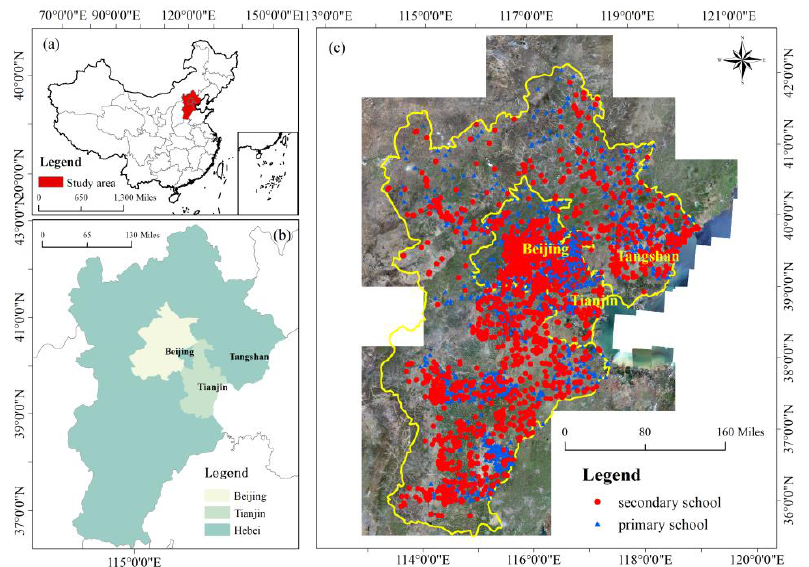
Figure 6. Display of study area: ( a ) the study area in China; ( b ) the Beijing – Tianjin – Hebei region; ( c ) the datasets used in our study. Note: the secondary and primary schools are plotted by the red circles and blue triangles, respectively.